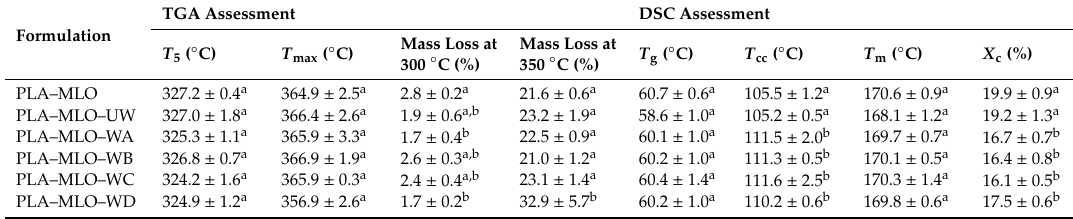
Table 2. Thermal properties of PLA–wool FRP studied